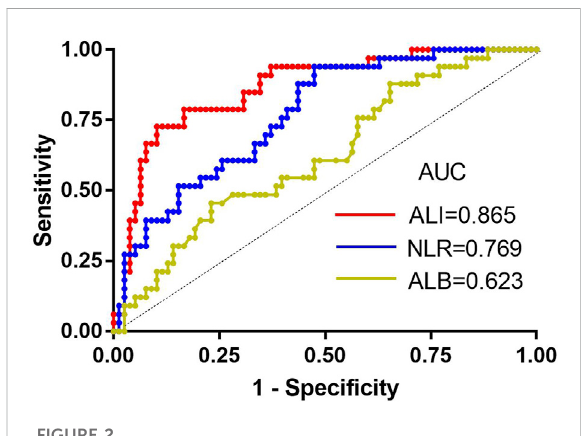
FIGURE 2 The receiver-operating characteristic (ROC) curves for ALI, ALB, and NLR. AUC, area under the curve; ALI, advanced lung cancer in fl ammation index; NLR, neutrophil-to-lymphocyte ratio; ALB,